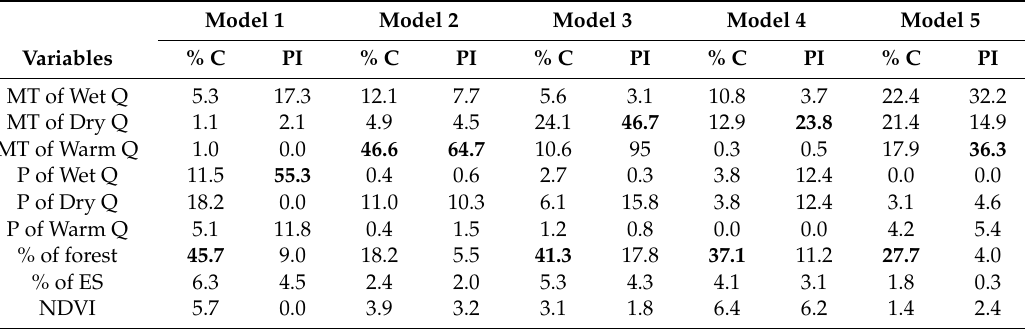
Table 8. Presented are the percent contribution (% C) and permutation importance (PI) for each environmental predictor variable with the highest contribution in bold for each Model. All temperature variables are in ( ◦ C) and all precipitation variables are in (mm). Abbreviations are: Mean Temperature (MT), Wettest (Wet), Driest (Dry), Warmest (Warm), Quarter (Q), Percentage (%) Precipitation (P), Early successional (ES), and Land surface temperature